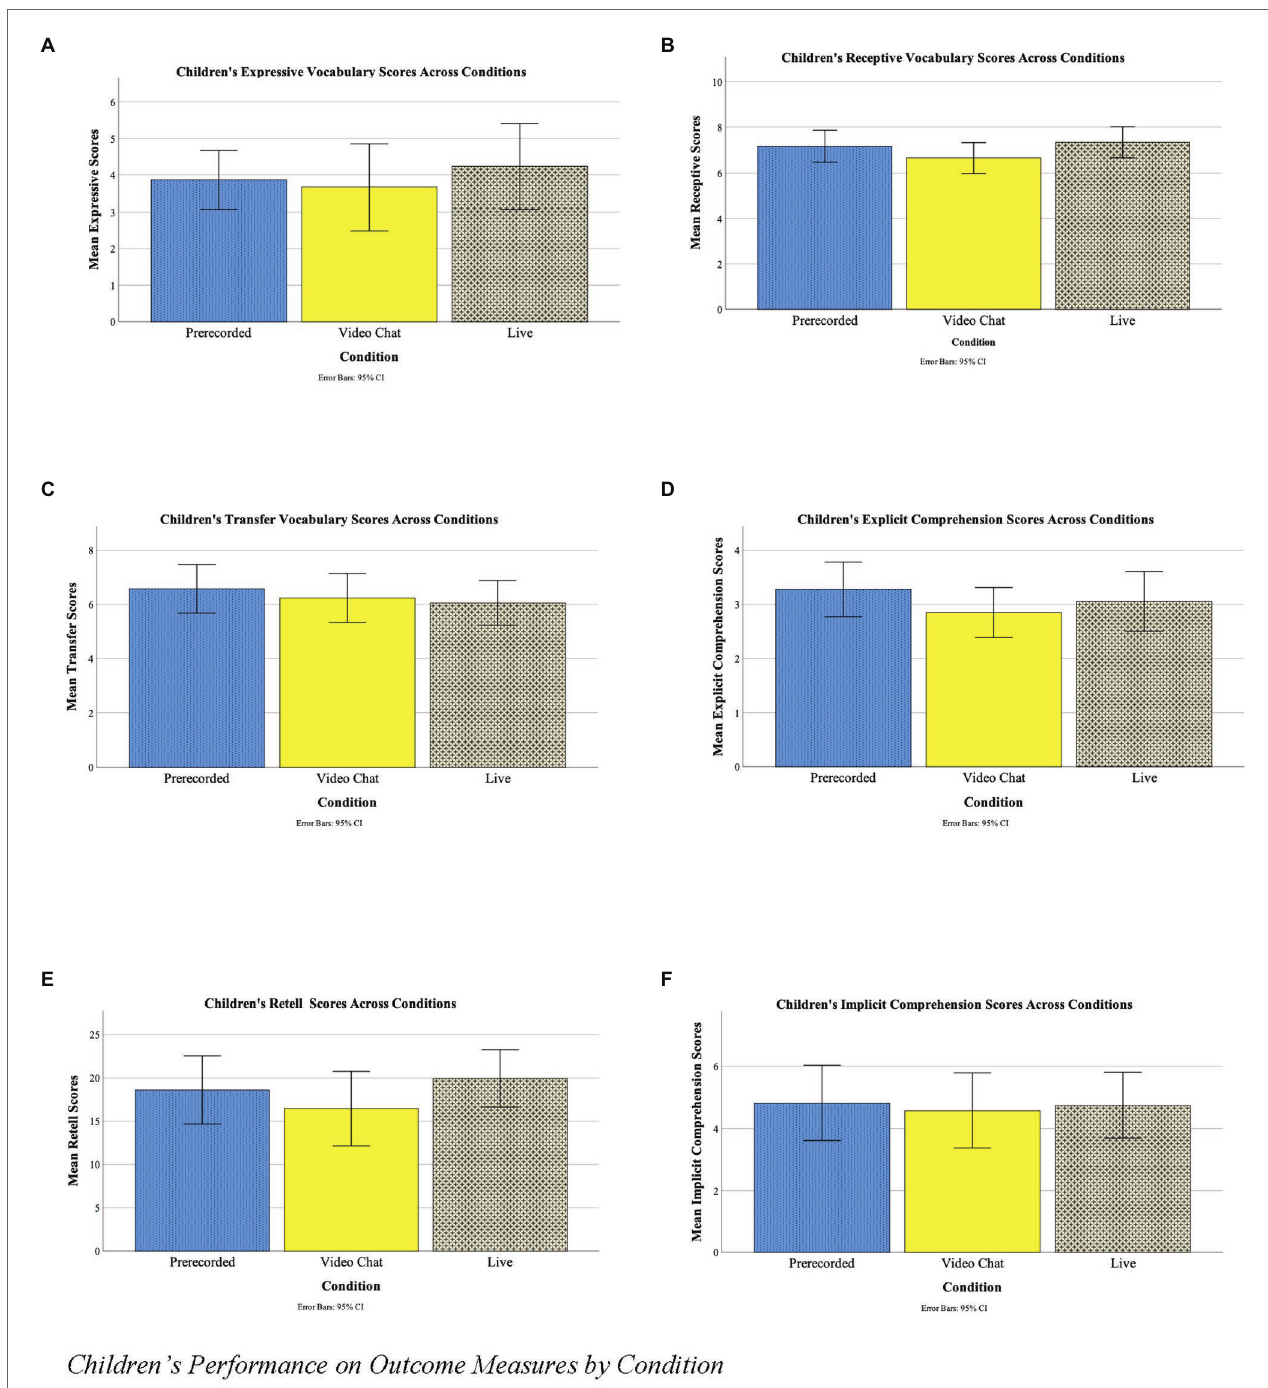
FIGURE 1 | Children’s performance on outcome measures by condition. (A) Children’s expressive vocabulary scores across conditions. (B) Children’s receptive vocabulary scores across conditions. (C) Children’s transfer vocabulary scores across conditions. (D) Children’s explicit comprehension scores across conditions. (E) Children’s retell scores across conditions. (F) Children’s implicit comprehension scores across